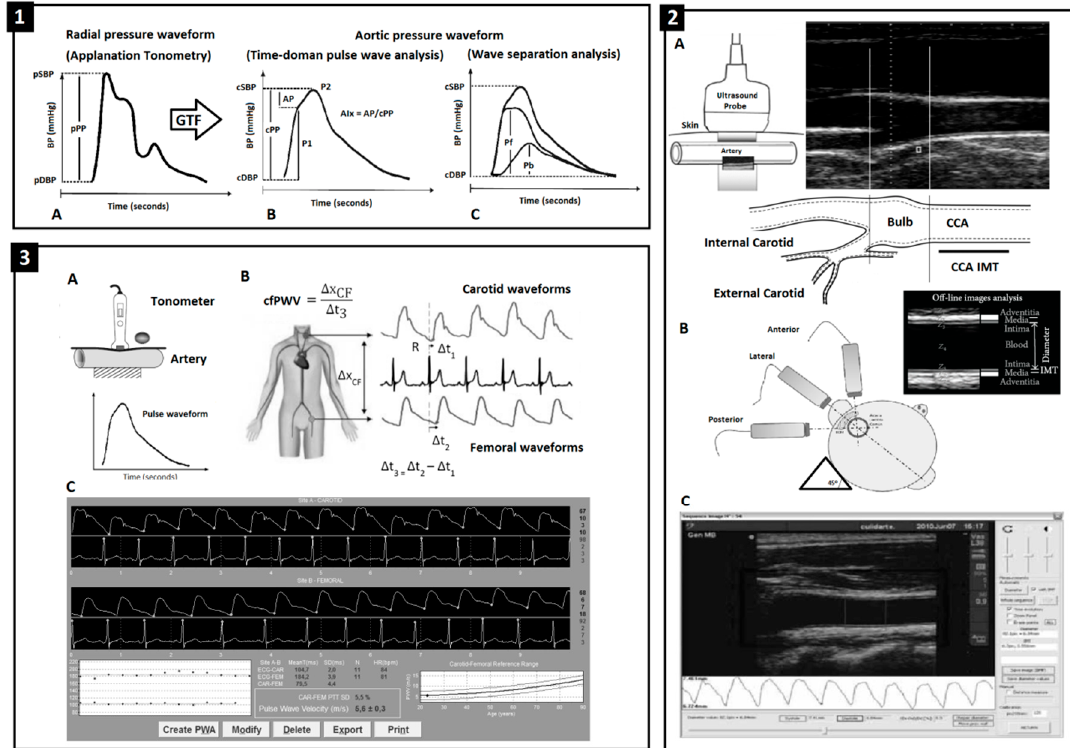
Figure 1. 1-A: Radial pulse wave obtained by applanation tonometry (SphygmoCor device); pSBP, pDBP, pPP: peripheral systolic, diastolic and pulse pressure. GTF: general transfer function. 1-B: Aortic